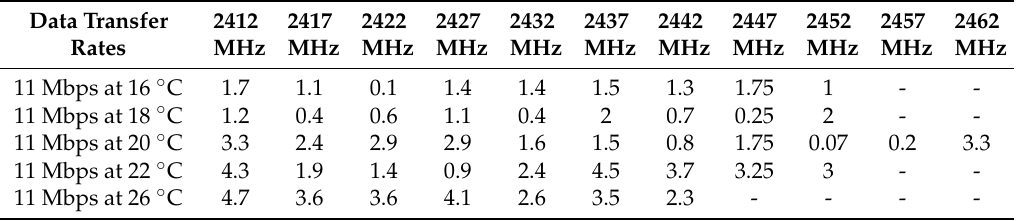
Table 9. Calculation of residuals for CCK at 11